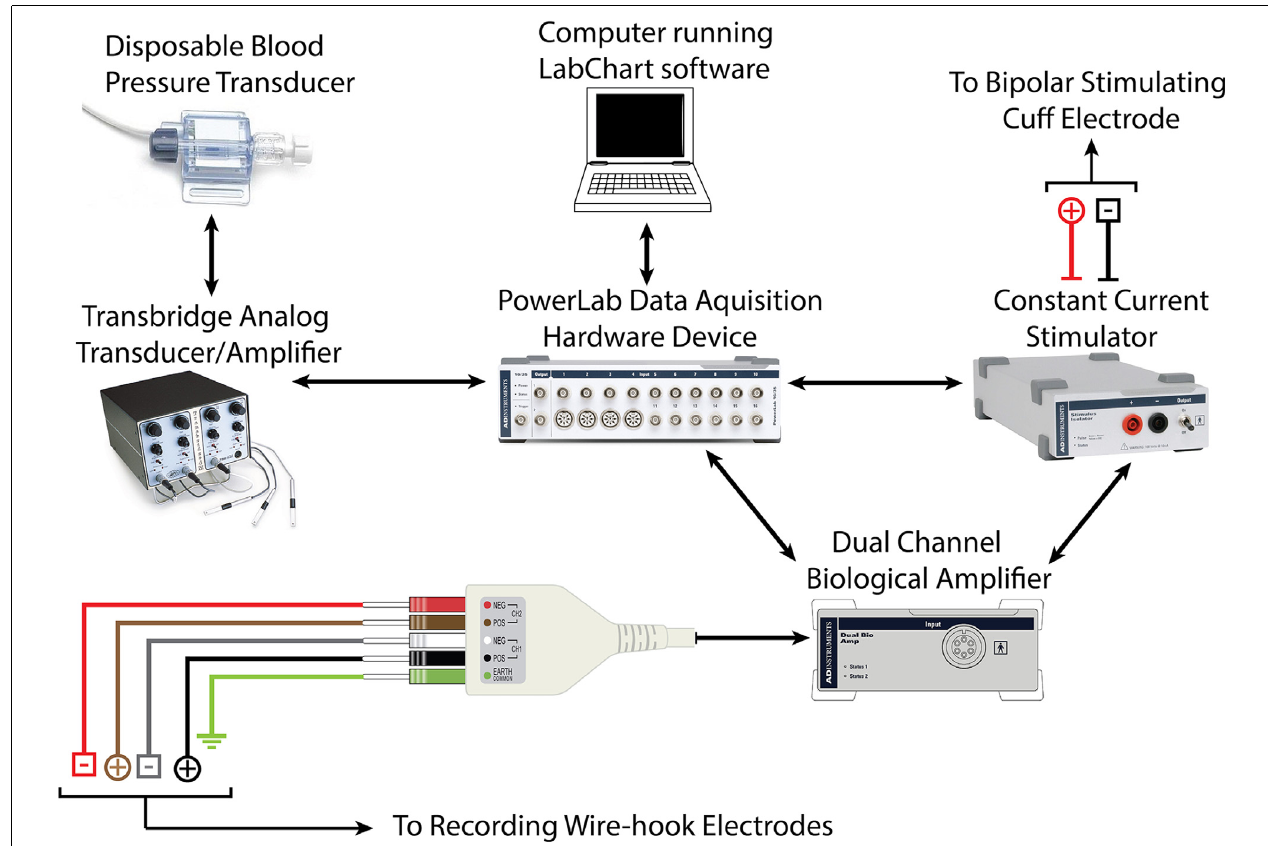
FIGURE 2 | Schematic demonstrating hardware requirements for recording CMAP and force-impulse of crush lesion using forceps instrumented with a force